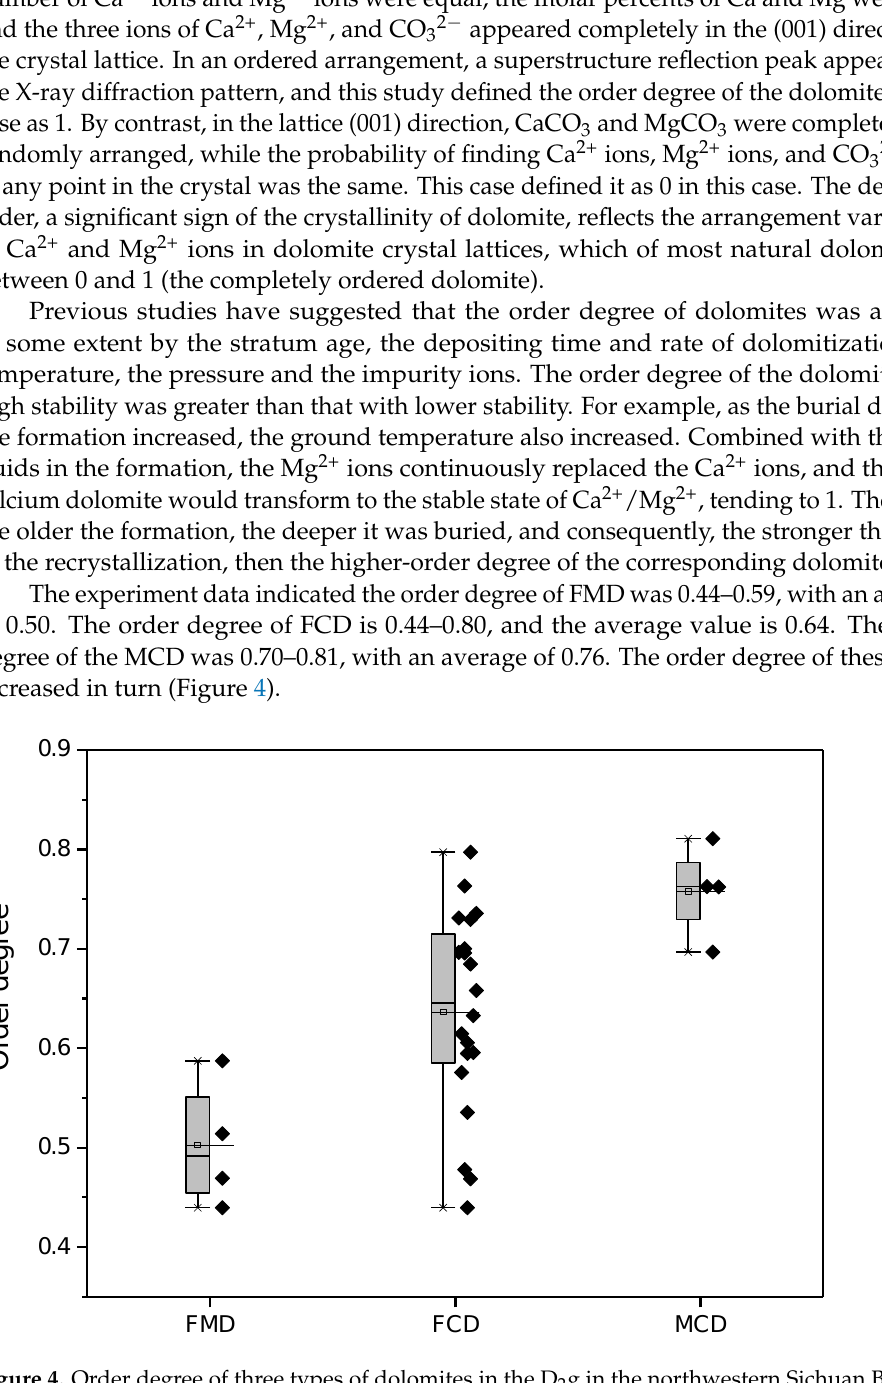
Figure 4. Order degree of three types of dolomites in the D 2 g in the northwestern Sichuan Basin.